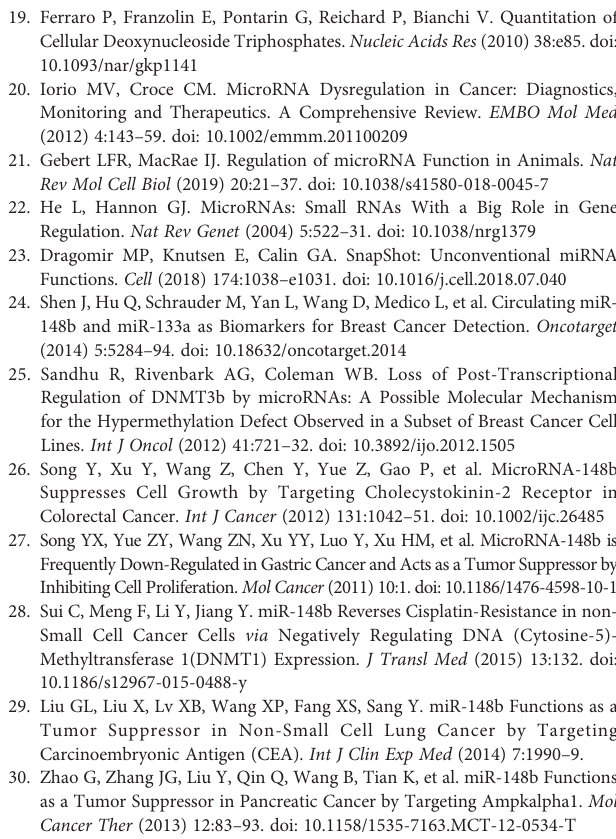
Supplementary Figure 3 | Validation of MET, ERK2, IL-6, and NF-kB expression in HCC patients. (A) Levels of MET, ERK2, IL-6, and NF-kB were assessed via IHC.